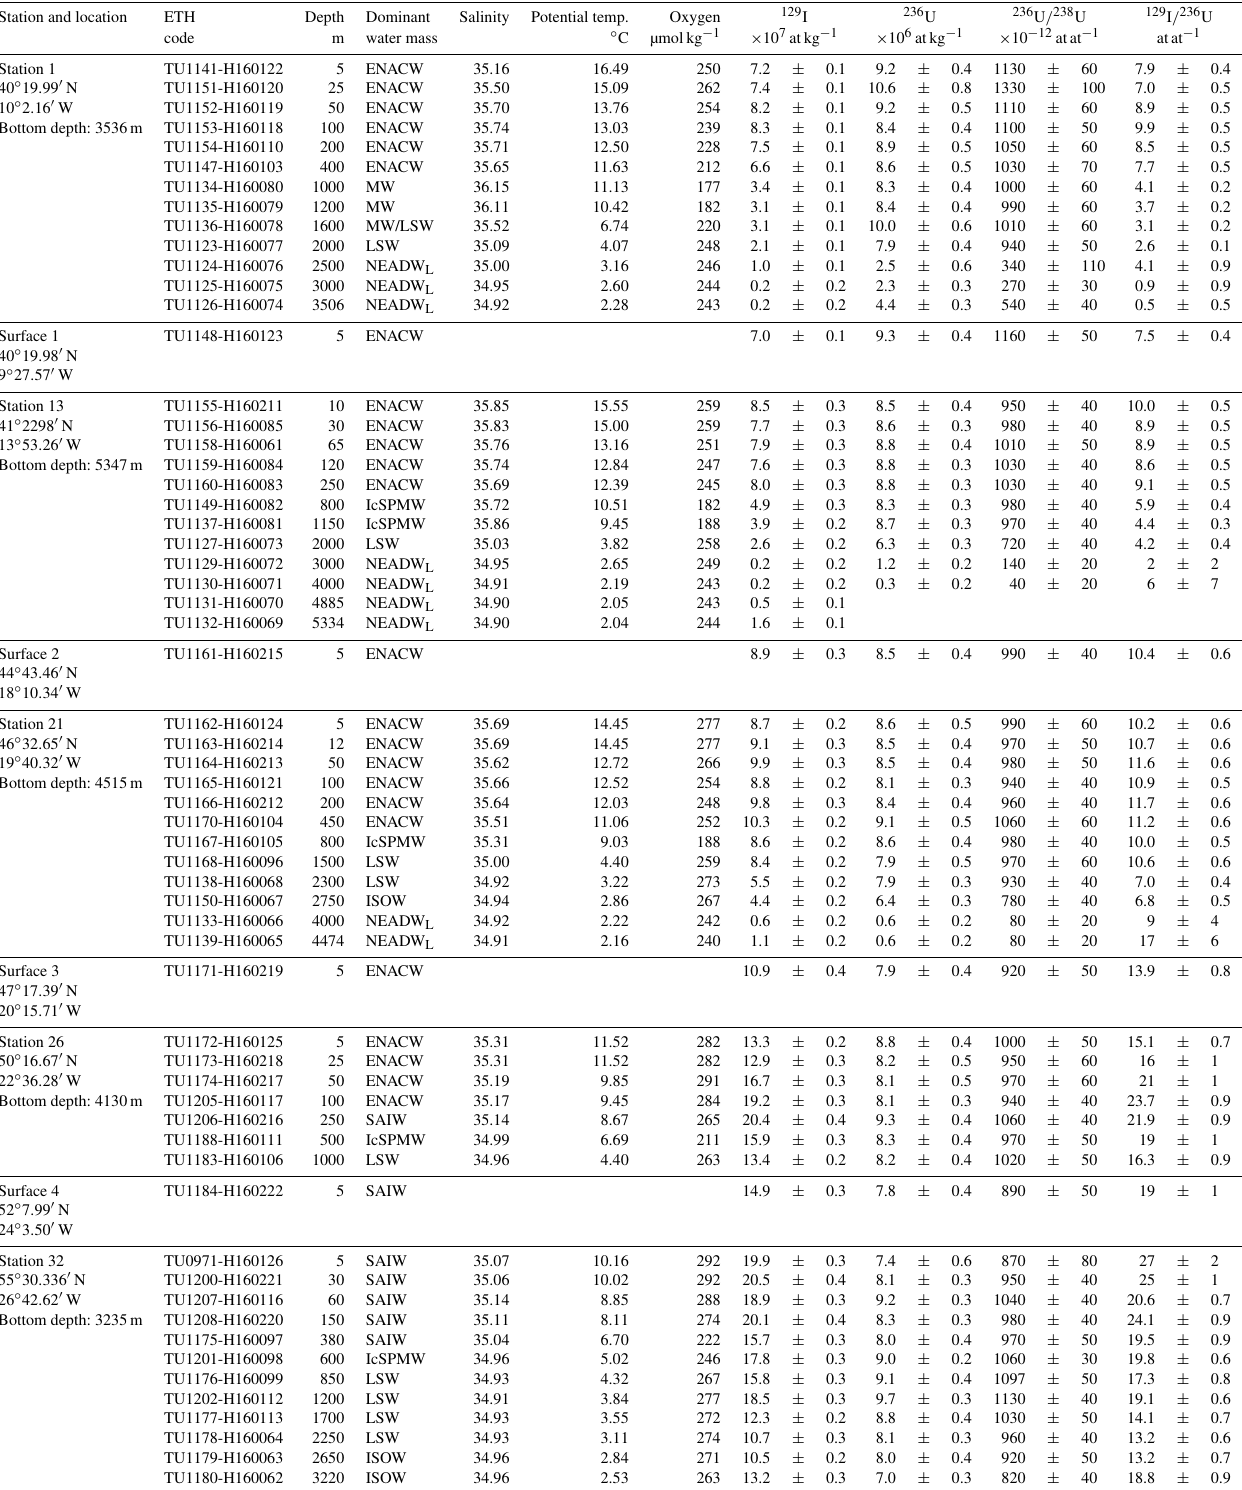
Table 1. Concentrations of 129 I and 236 U, and atom ratios of 236 U / 238 U and 129 I / 236 U in seawater samples collected during the GEOVIDE cruise in spring 2014. Uncertainties of radionuclide concentrations and the 236 U / 238 U ratio are given as 1 σ deviations. The uncertainty of the 129 I / 236 U ratio was propagated from the concentration uncertainty. * 236 U data are corrected for cross talk contamination. Temp. stands for